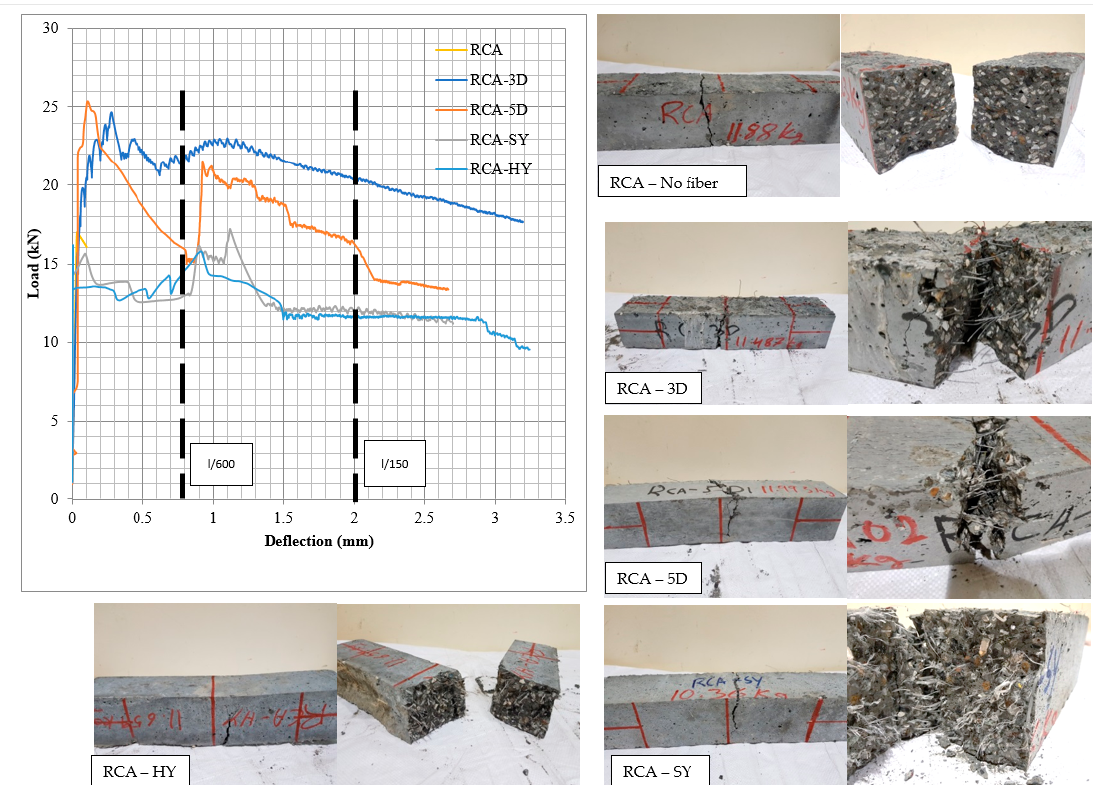
Figure 10. Load-deflection curves for flexural performance of fiber-reinforced recycled concrete and mode of failures.